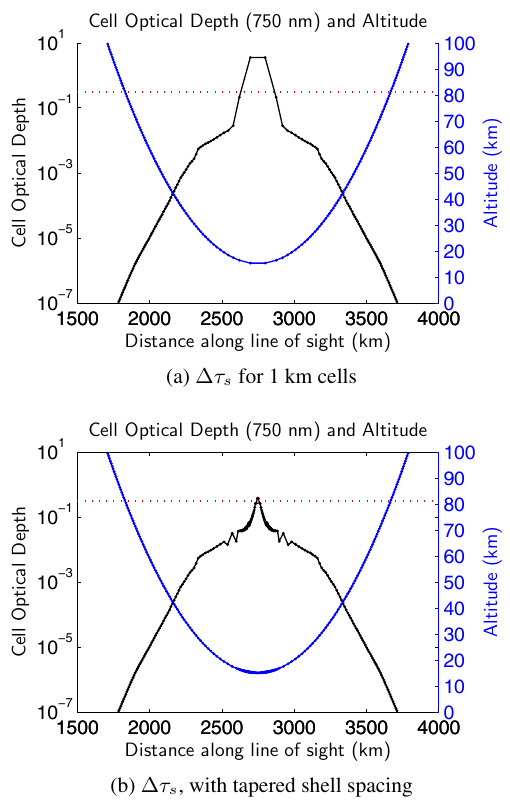
Fig. 3: Cell optical depths, ∆ τ s , shown as a function of dis- along observer line of sight. tance s along observer line of sight.